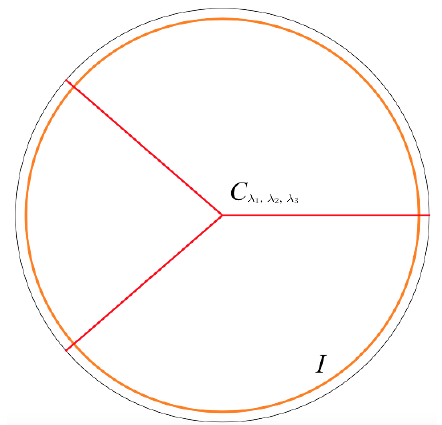
Figure 5 . An example of a three-particle bulk interaction vertex corresponding to the junction of three Wilson lines de(cid:12)ned by a Clebsch-Gordan coe(cid:14)cient at the vertex. truncated by the cut-o(cid:11) (cid:4). Such a non-local object is schematically represented in (cid:12)gure